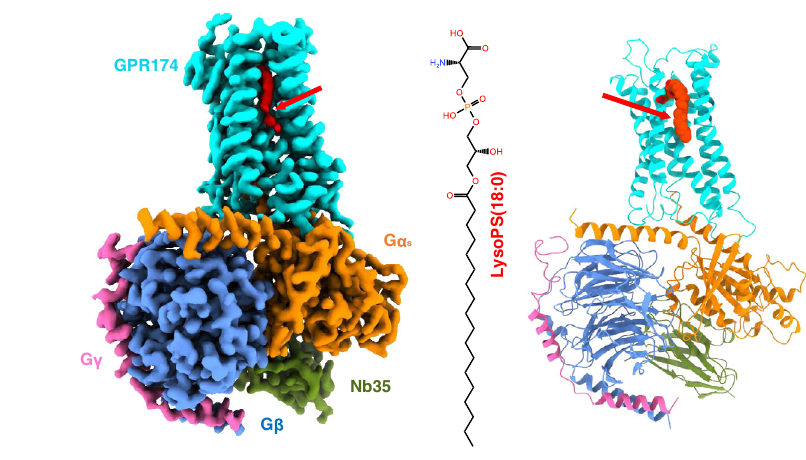
Fig.1|TheoverallstructureofGPR174/G s complex. Leftpanel,orthogonalviewsofthecryo-EMdensitymapoftheGPR174/G s complex;therightpanel,amodelofthe complex in the same view and color scheme as shown in the left